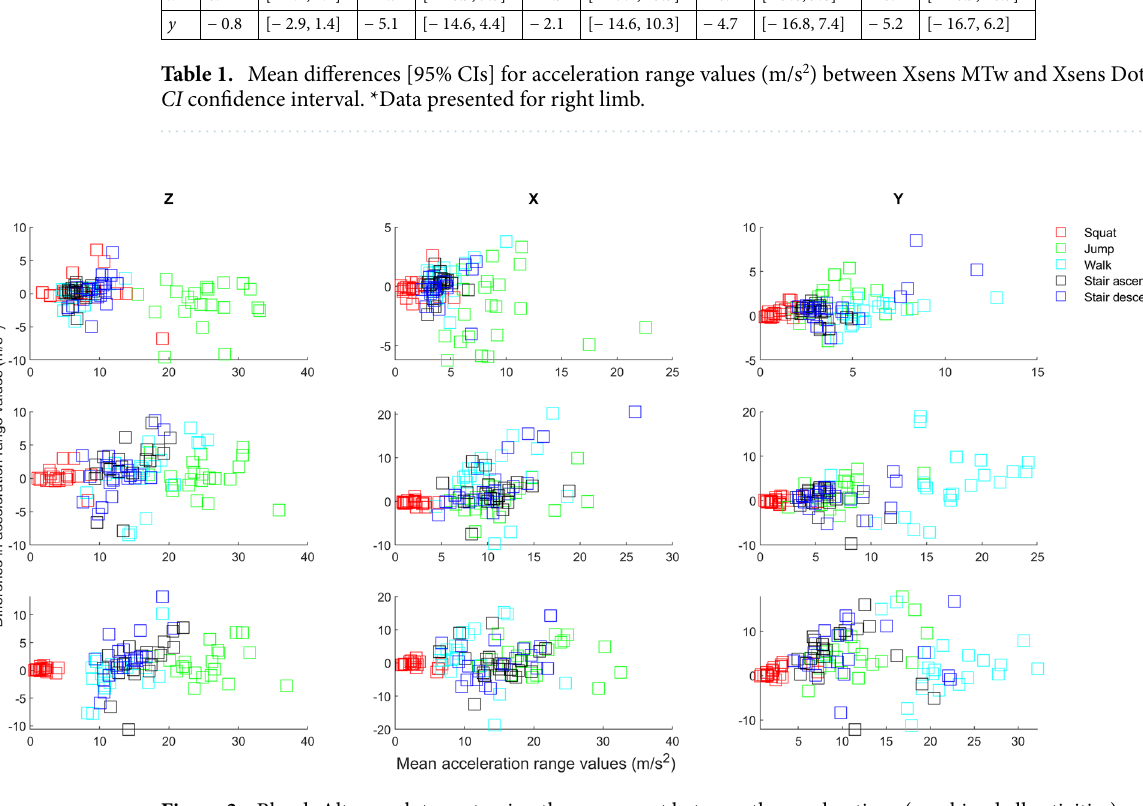
Figure 3. Bland–Altman plots portraying the agreement between the accelerations (combined all activities) collected using the Xsens MTw and Xsens Dot. Y axis—Difference in acceleration range values between the Xsens MTw and Xsens Dot; X axis—Mean acceleration range values of the Xsens MTw and Xsens